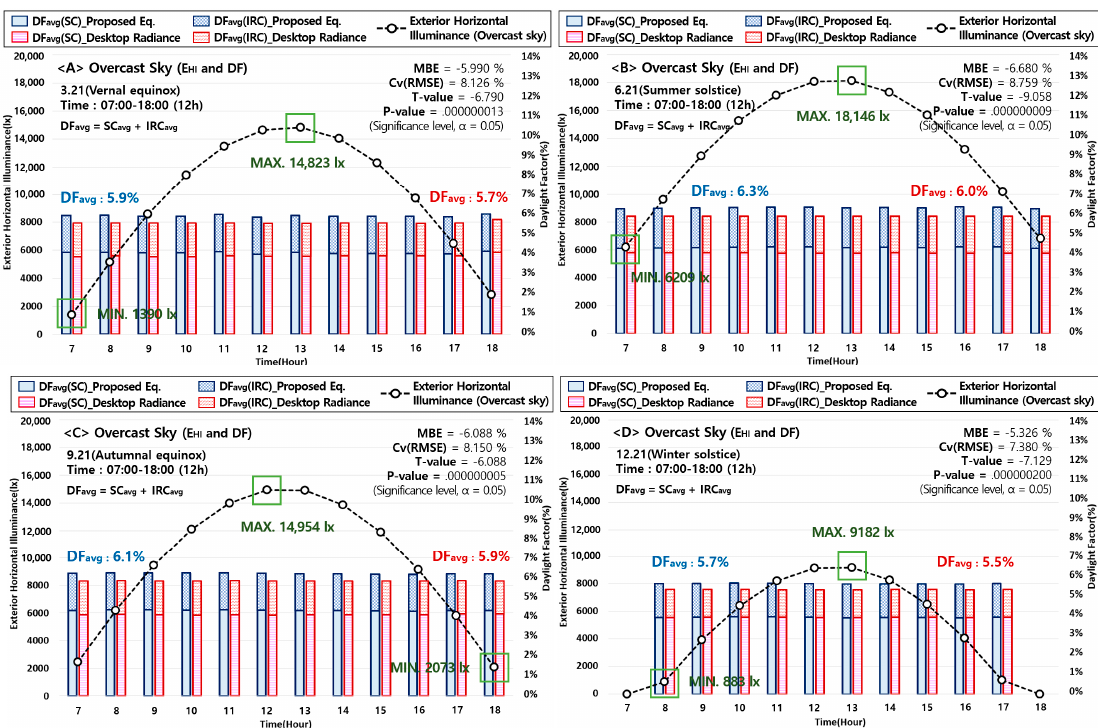
Figure 13. Comparison of daylight factor between the modified equation and Desktop Radiance simulation in CIE overcast sky ( A ) 3.21 ( B ) 6.21 ( C ) 9.21 ( D ) 12.21 (07:00–18:00).